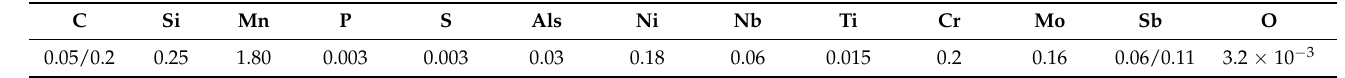
Table 2. Initial target compositions of molten low-carbon steel (wt%).